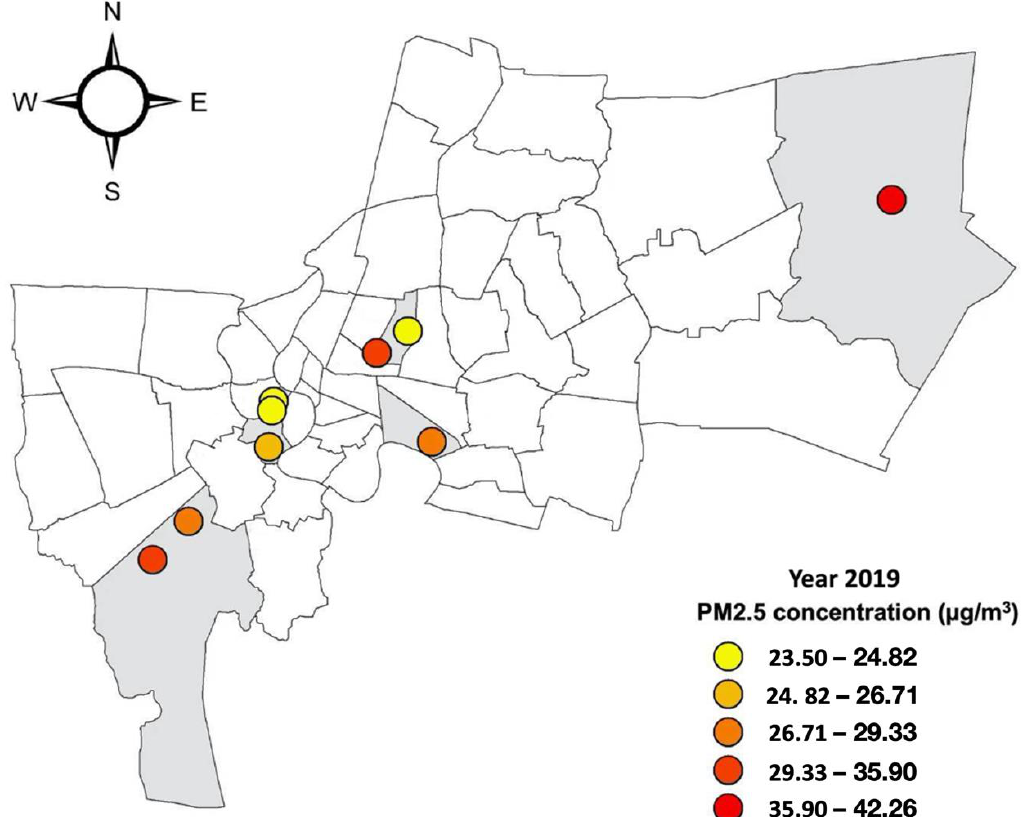
Figure 1. Study area and annual PM 2.5 concentration in